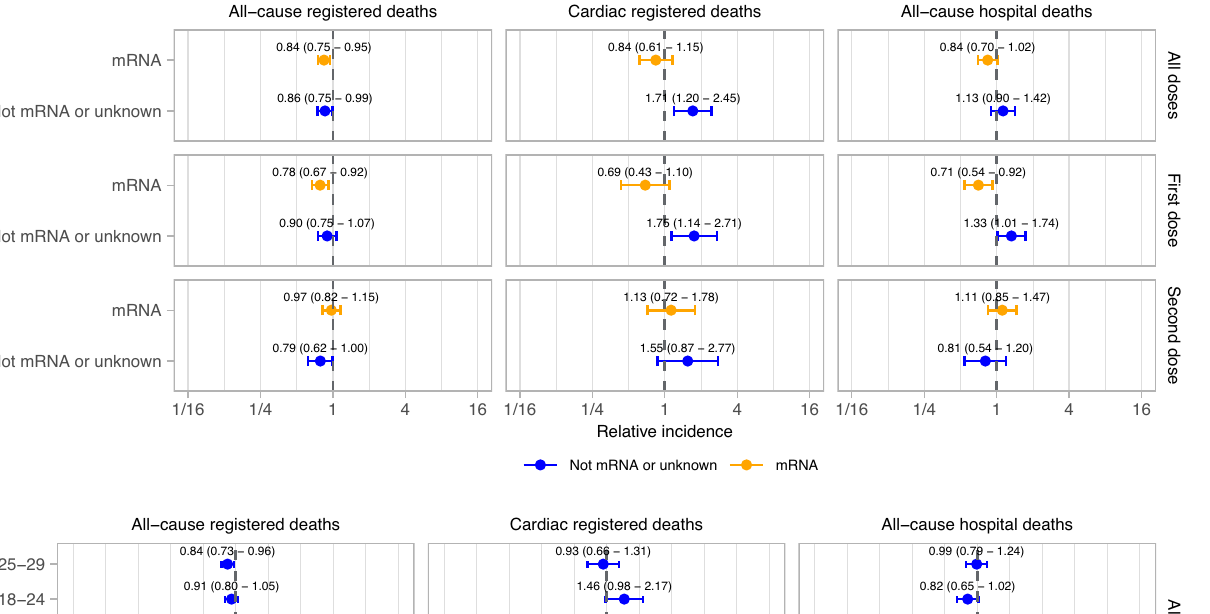
Fig.2| Relativeincidenceofcardiacandall-causedeathintheriskperiodafter vaccination, compared to the baseline period, by sex, age group and vaccine vector. Data are presented as incidence rate ratio with 95% con fi dence intervals. Models are adjusted for calendar time. n = 3807 all-cause registered deaths, 444